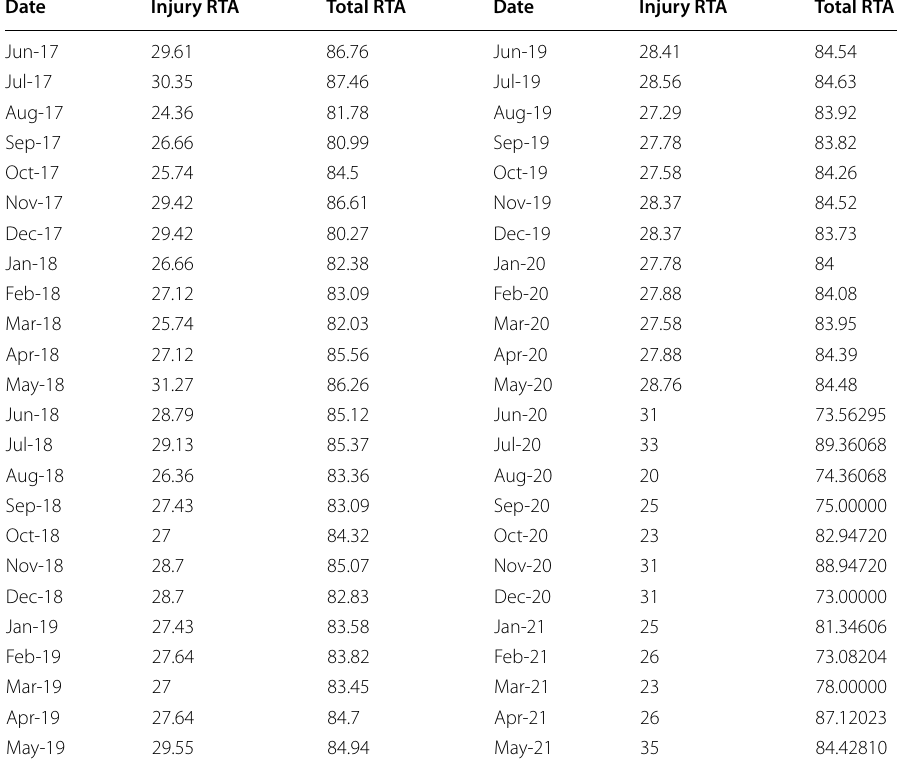
Table 7 Predicted counts of injury and total road traffic accidents from June 2017 to May 2021